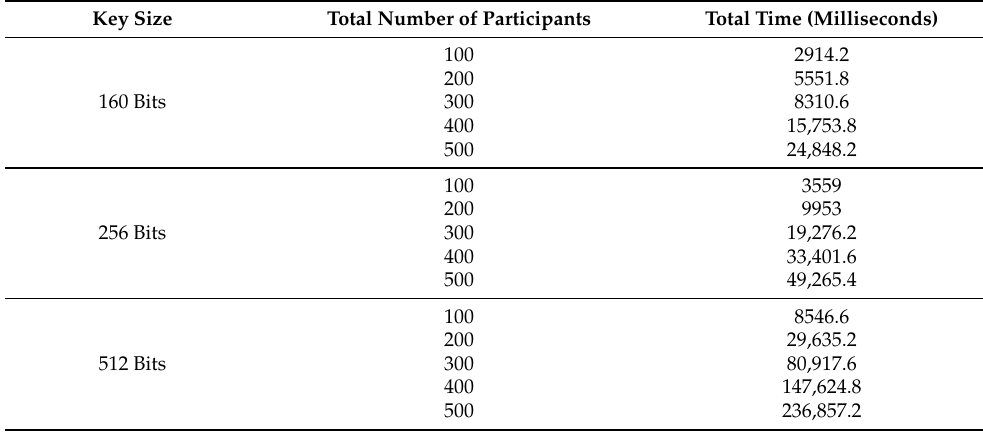
Table 6. Total time taken by the Group Key Diffie–Hellman scheme. Key Size